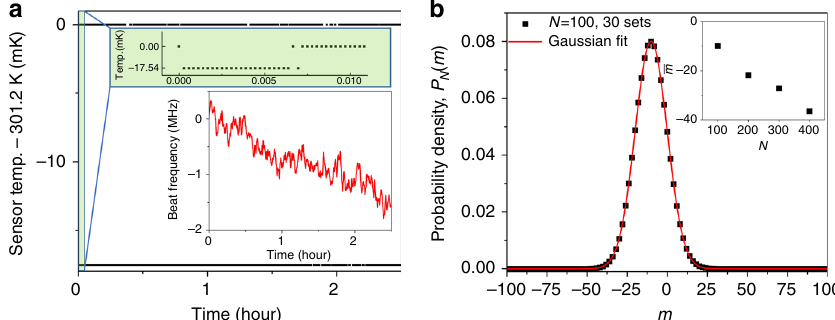
Fig. 5 Thermistor sensor temperature random walk distribution statistics. a The 10 k Ω thermistor sensor temperature measurement data. Due to the temperature digitization, the measurement resolution is limited such that the upper and lower temperature bounds per every one second are recorded. Inset : resonance frequency shift during the temperature measurement period. b The probability distribution for N = 100, P N = 100 (m) , where m is located at − 10.05 ffiffiffiffi p and ð Δ m Þ 2 is 9.97, which is approximately N demonstrating that this measurement follows the random walk distribution. The inset shows that the increased number of samples monotonically shifts m far from the